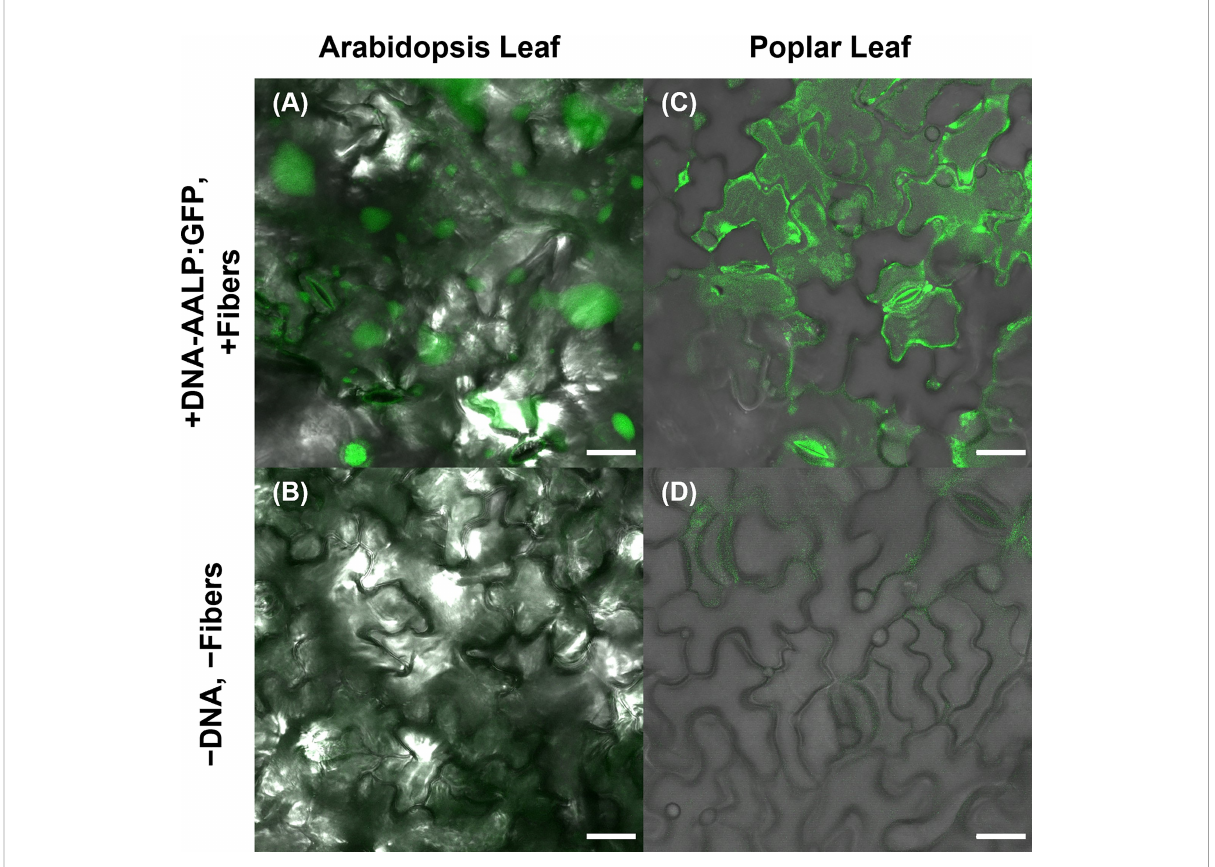
FIGURE 4 Use of VACNF to introduce DNA expression constructs into poplar leaves. Images were generated using confocal fl uorescence microscopy. VACNFs delivered a small plasmid resulting in expression of a vacuolar marker, AALP:GFP (shown in green). (A) Arabidopsis leaf 48 h after delivery of p35S:AALP:GFP/pUC via fi bers with 20 µm pitch (+DNA-AALP:GFP, + fi bers), (C) Poplar leaf 48 h after delivery via fi bers with 10-µm pitch (+DNA-AALP:GFP, + fi bers). (B, D) Show untreated controls ( − DNA, − fi bers). All images are maximum projections of 40 m m z-stacks. Scale bar = 20